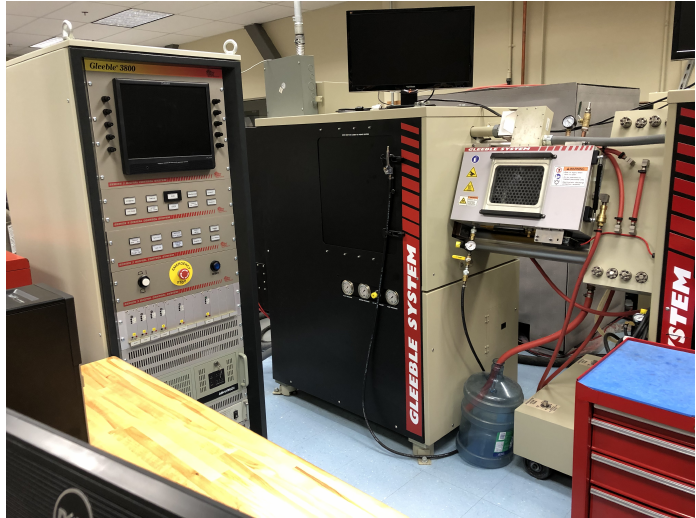
Figure 1. The Gleeble-3800 thermomechanical simulator system used for this study. Thin tantalum sheets were used as the lubricating material at the contact surface of the anvils and samples to minimize friction during testing. Figure 2 shows the inside of the Gleeble thermomechanical simulator with the specimen in place. We used 3 thermocouples soldered to the specimen to record the temperature history during the test and to ensure that the specimen was at the correct temperature prior to